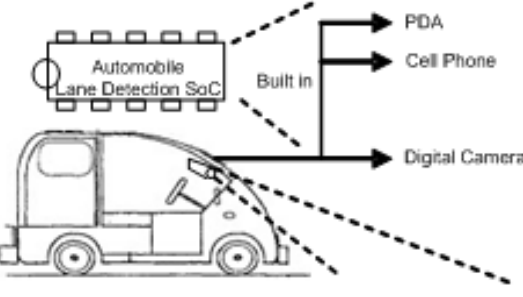
Figure 1. The automobile lane detector integrated with CMOS imager for use in